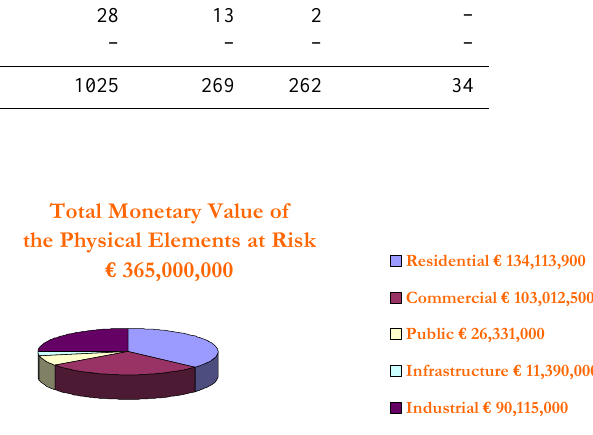
Figure 5. Estimated total monetary value of the buildings within the inundation zone. 2 Fig. 5. Estimated total monetary value of the buildings within the inundation